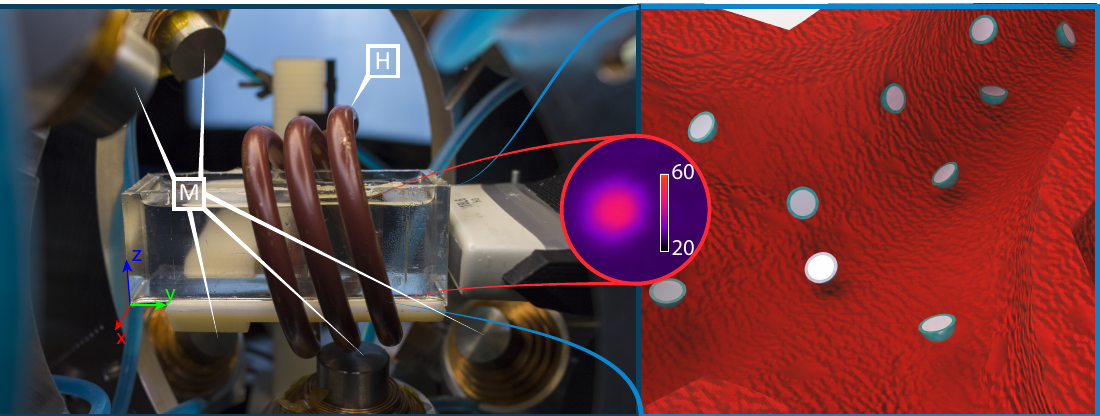
Figure 1. ( Left ) A close-up image of the used setup depicting the ultrasound probe, as well as the (cid:16) (cid:17) (cid:16) (cid:17) coils used to generate high frequency H and quasi-static magnetic fields M . ( Central inset ) One of the used microrobots after 15 s of induction heating (18 mT at 126 kHz), captured using a cooled-detector thermal camera with 12 mm extension ring (FLIR Systems, Wilsonville, OR, USA). Scalebar in degree Celsius. ( Right ) Illustration of (sectioned) proposed microrobots navigating a blood vessel to perform targeted drug delivery.